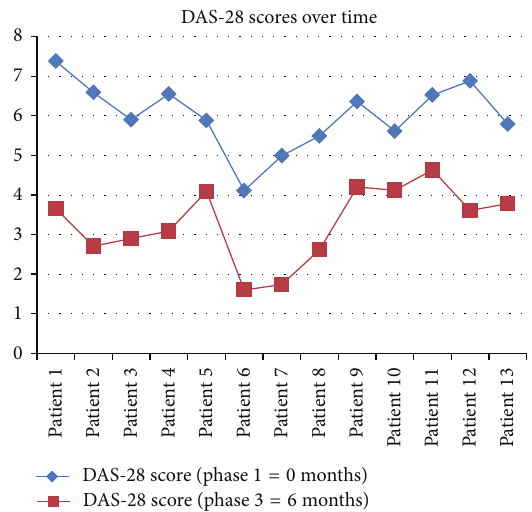
Figure2:IllustrationoftheDAS-28scoresreportedbyeverypatient at baseline (prior to initiation of TNF- 𝛼 inhibitor therapy) and at phase 3 (6 months after initiation of TNF- 𝛼 inhibitor therapy).